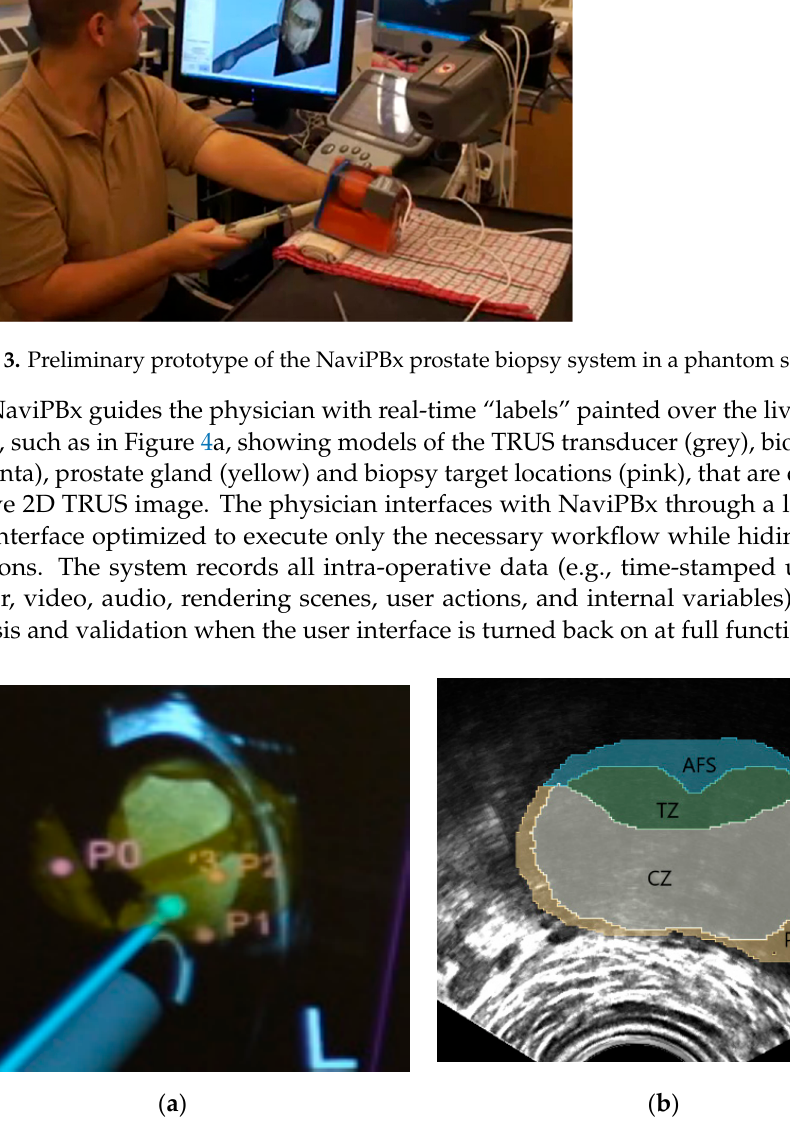
Figure 4. Typical system guidance views of the NaviPBx prostate biopsy system. ( a ) Models of the TRUS transducer (grey), biopsy needle (magenta), prostate gland (yellow), and the biopsy target locations (pink), that are overlaid on the live 2D TRUS image. ( b ) McNeal zones painted on the live 2D TRUS image.